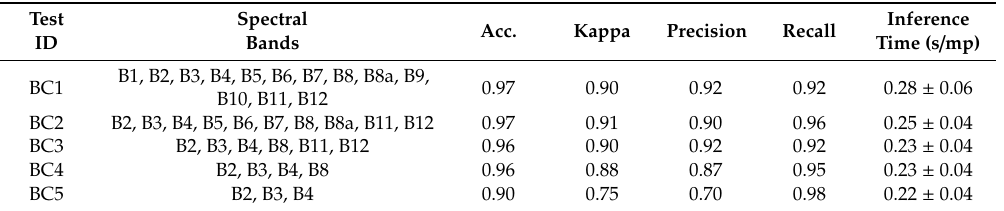
Table 2. Summary of the accuracy assessment and graphics processing unit (GPU) inference time for the 545 testing data tiles using di ff erent band combinations as input for the U-Net. The networks were trained on the non-augmented dataset until convergence occurred.